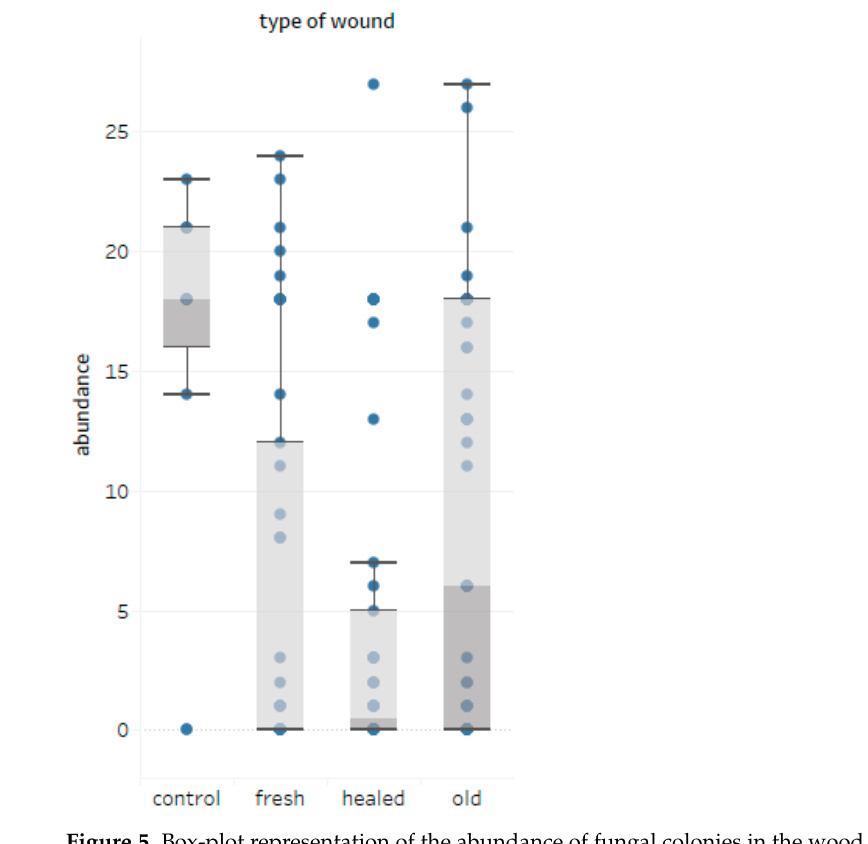
Figure 5. Box-plot representation of the abundance of fungal colonies in the wood sample, according to the type of wound on silver fir trunk. Table 4. The number of isolated fungi colonies inhabiting wounds depending on the DBH of bark-stripped firs.